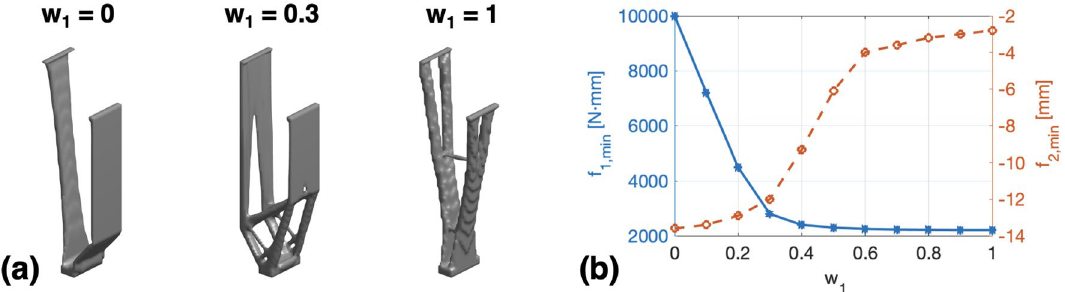
Figure 4. Compliant legs synthesized by using different weighting factors: ( a ) Synthesis results with w 1 = 0, 0.3, 1 , ( b ) Relationship between the minimized objective functions ( f 1, min and f 2, min ) and the weighting factor w 1 .